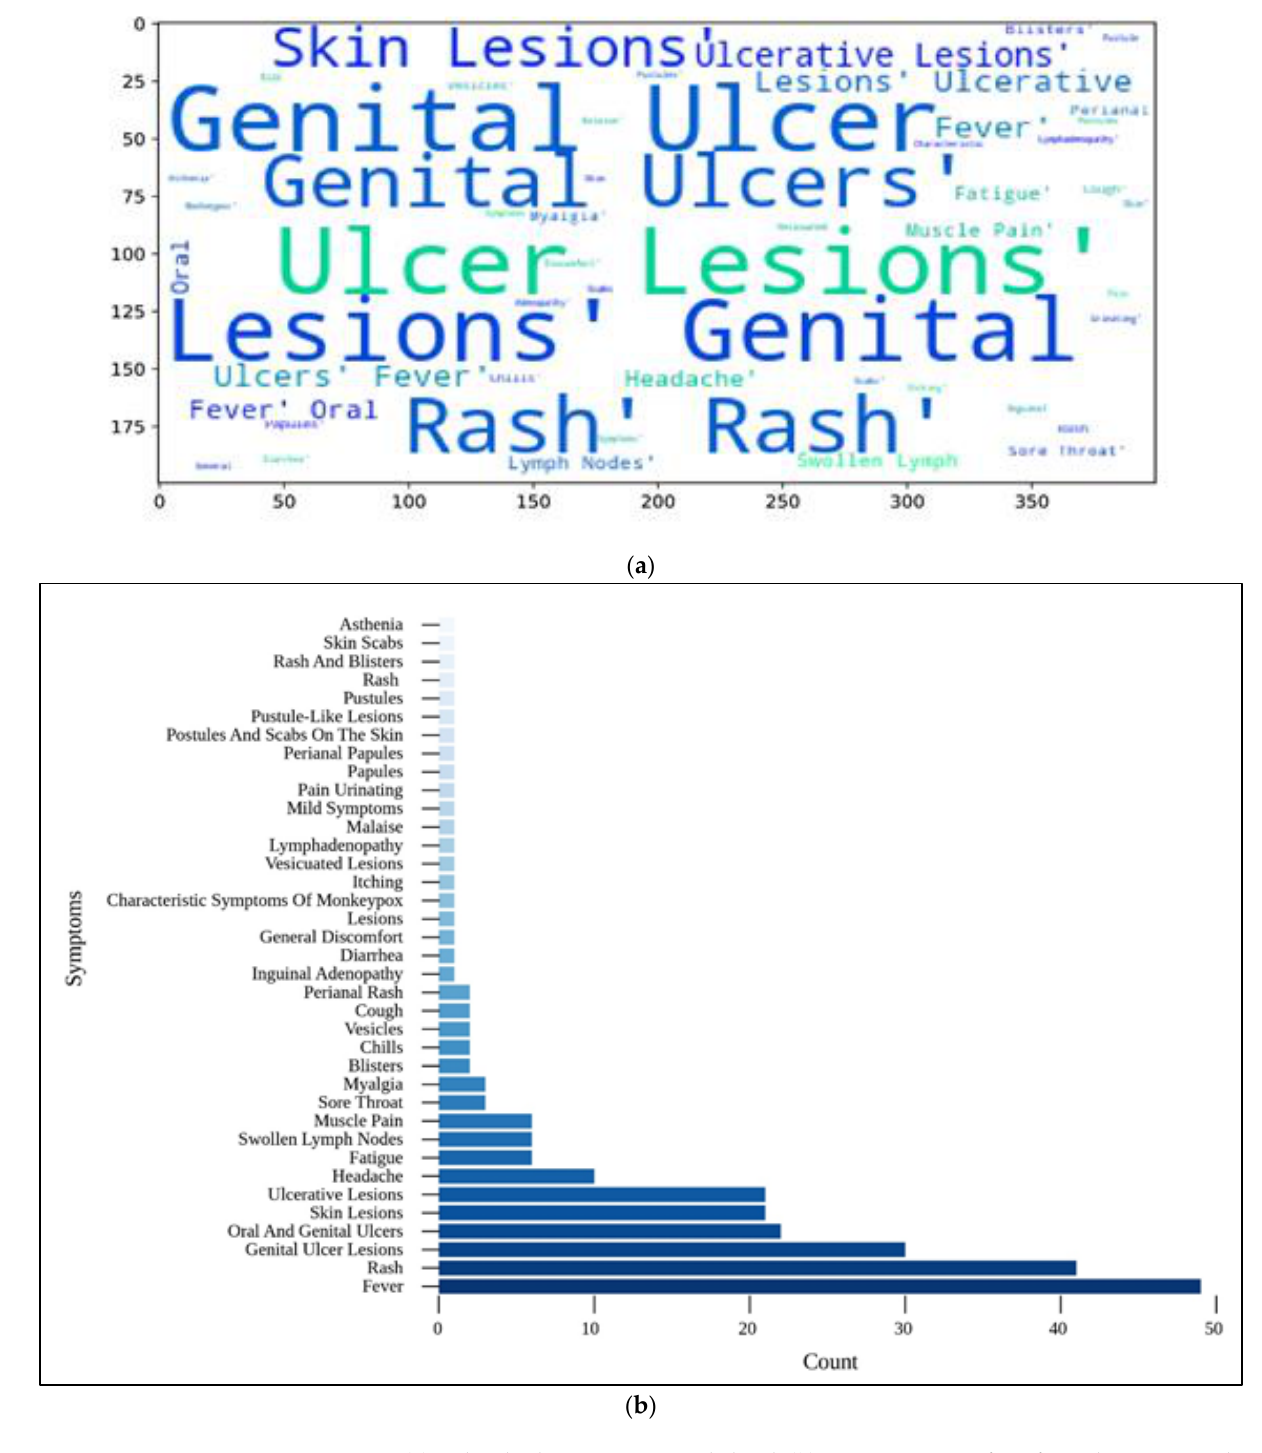
Figure 9. ( a ) Individual symptoms word cloud; ( b ) categorization of confirmed cases according to their respective symptoms.